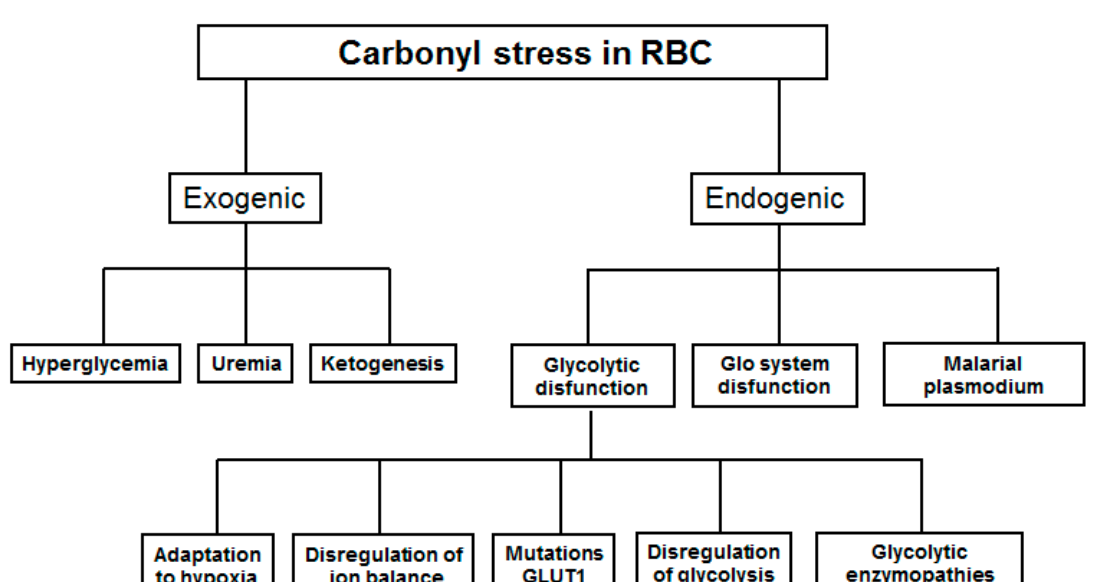
Figure 1. Ways of realization of carbonyl stress in red blood cells. GLUT1—glucose transporter, Glo—glyoxalase system.